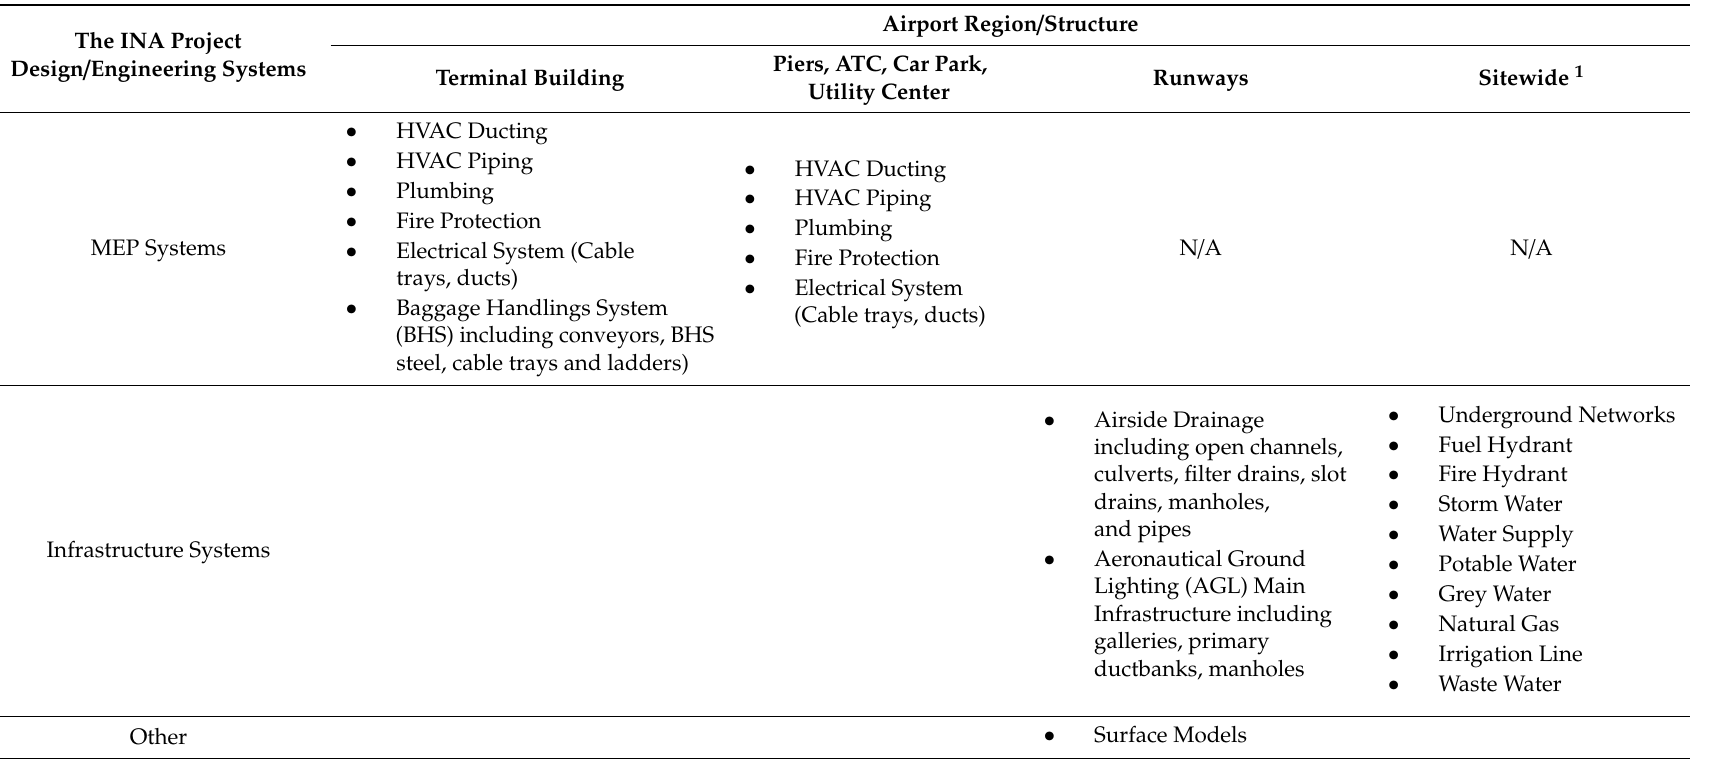
Table 1. Major modelled MEP and infrastructure systems according to their